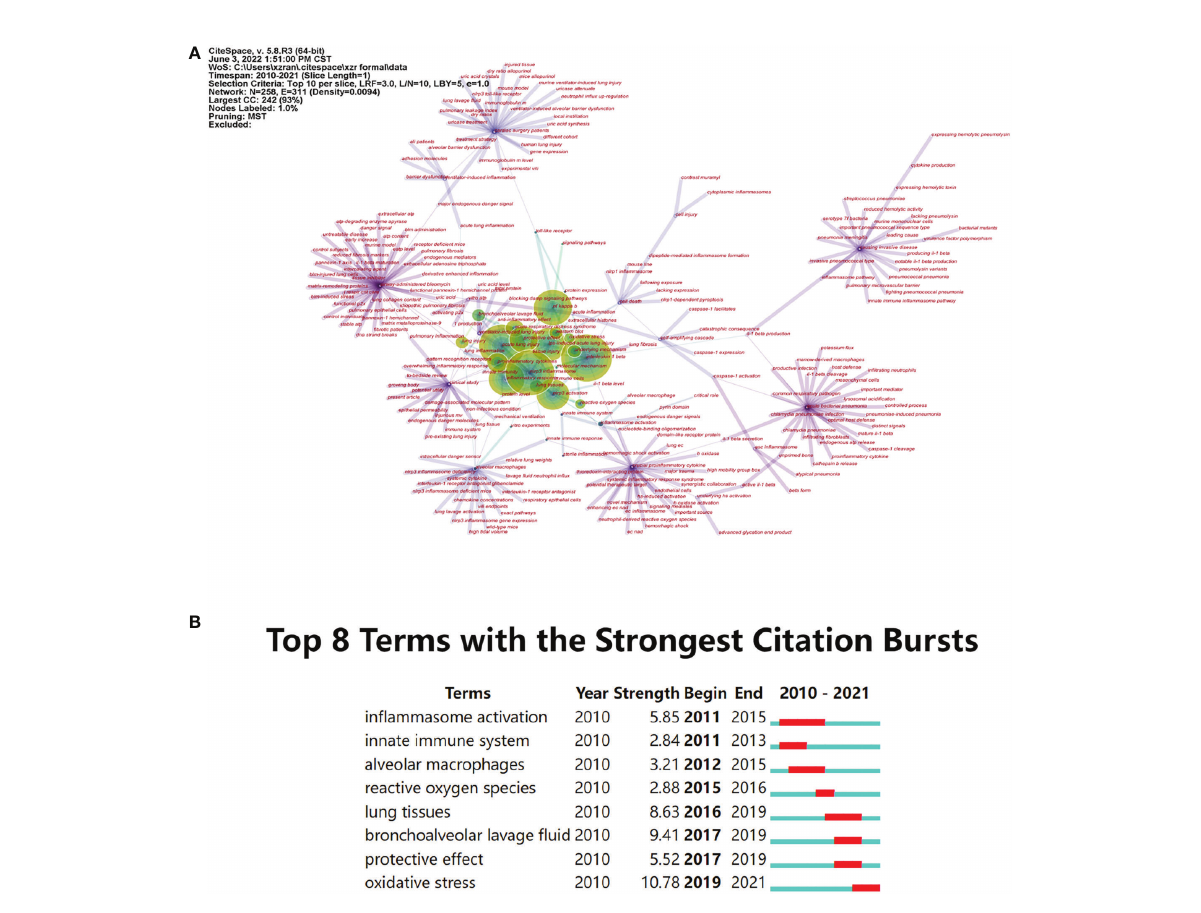
FIGURE 6 Co-occurrence analysis of terms of NLRP3 in ALI/ARDS. (A) The terms co-occurrence network of the 508 documents. Nodes represent noun phrases. Lines refer to co-occurring relationship. (B) The terms with the strongest citation